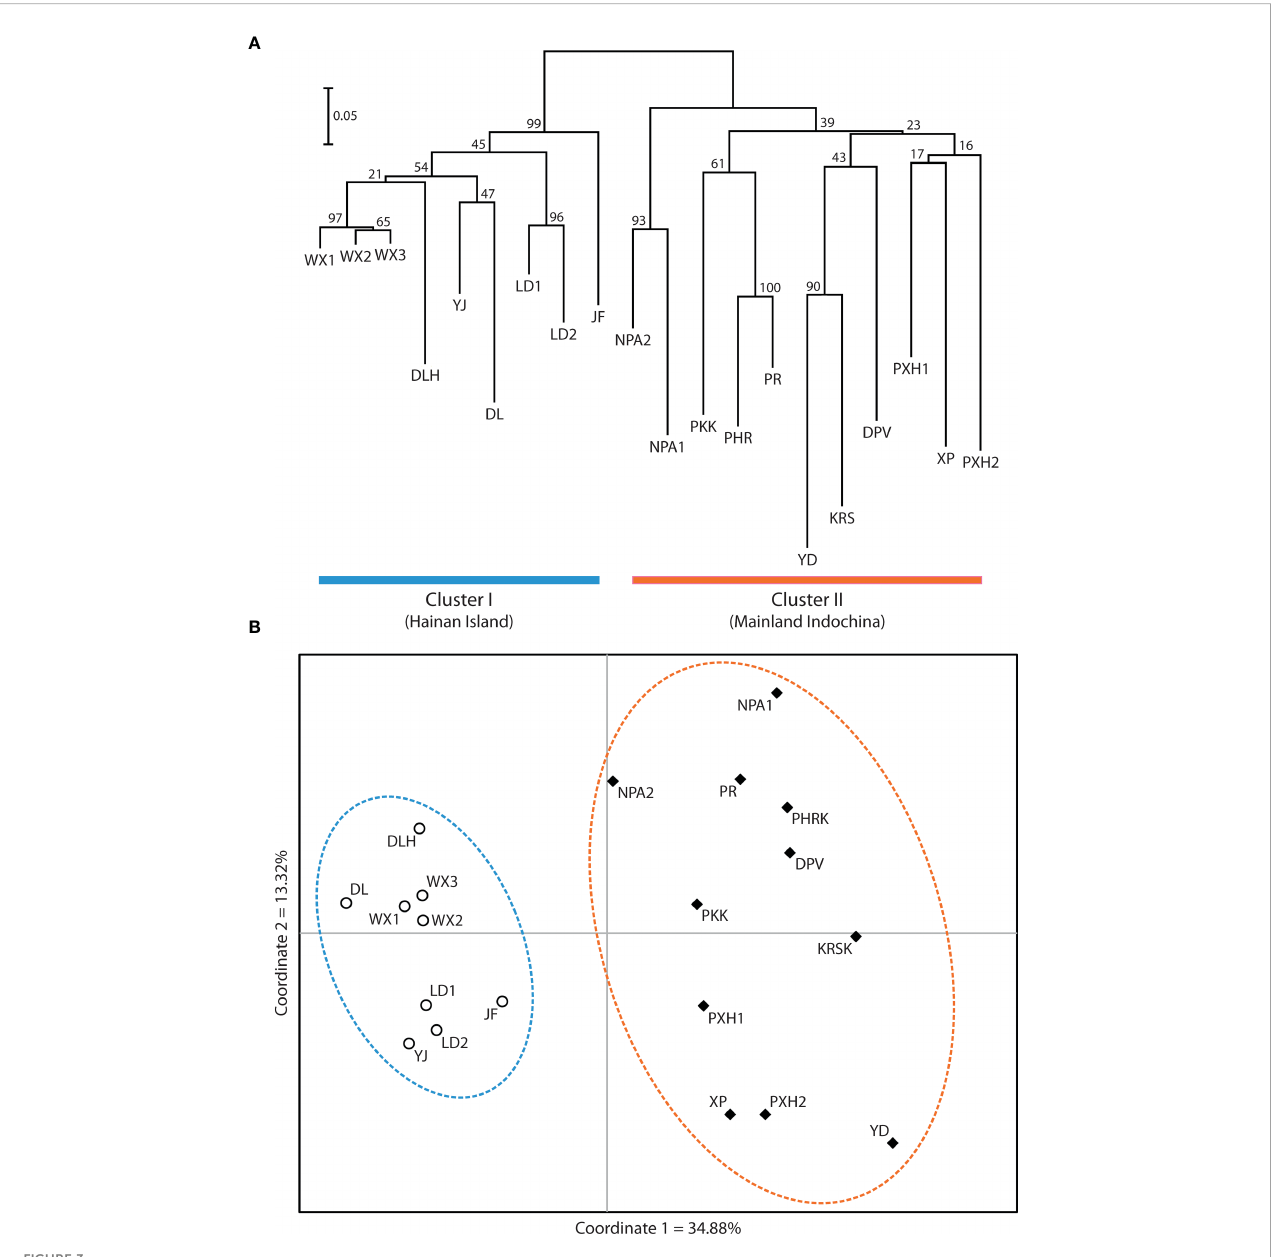
FIGURE 3 Relatedness among the 20 Phalaenopsis pulcherrima populations. (A) Relatedness inferred from neighbour-joining analysis of Nei ’ s genetic distances. Cluster I (blue) contains all nine populations located on Hainan Island, whereas Cluster II (orange) contains all 11 populations located in mainland Indochina. (B) Relatedness inferred from PCoA of pairwise genetic distance estimates. The same two clusters are resolved (the nine Hainan Island populations are indicated with open circles and a blue dashed line, and the 11 mainland Indochinese populations are indicated with fi lled diamonds and an orange dashed